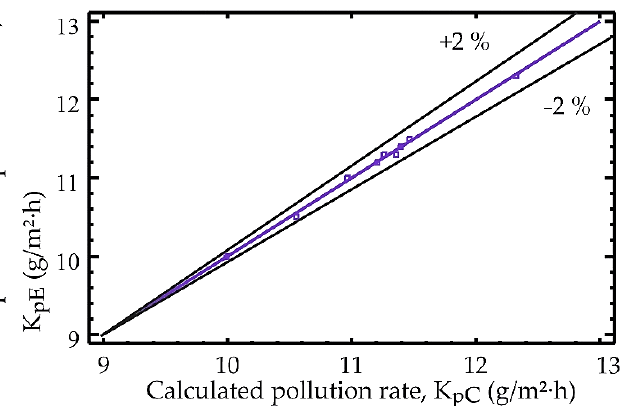
Figure 10. Comparison of calculated pollution rate K pC values with experimental K pE during the WFE combustion.